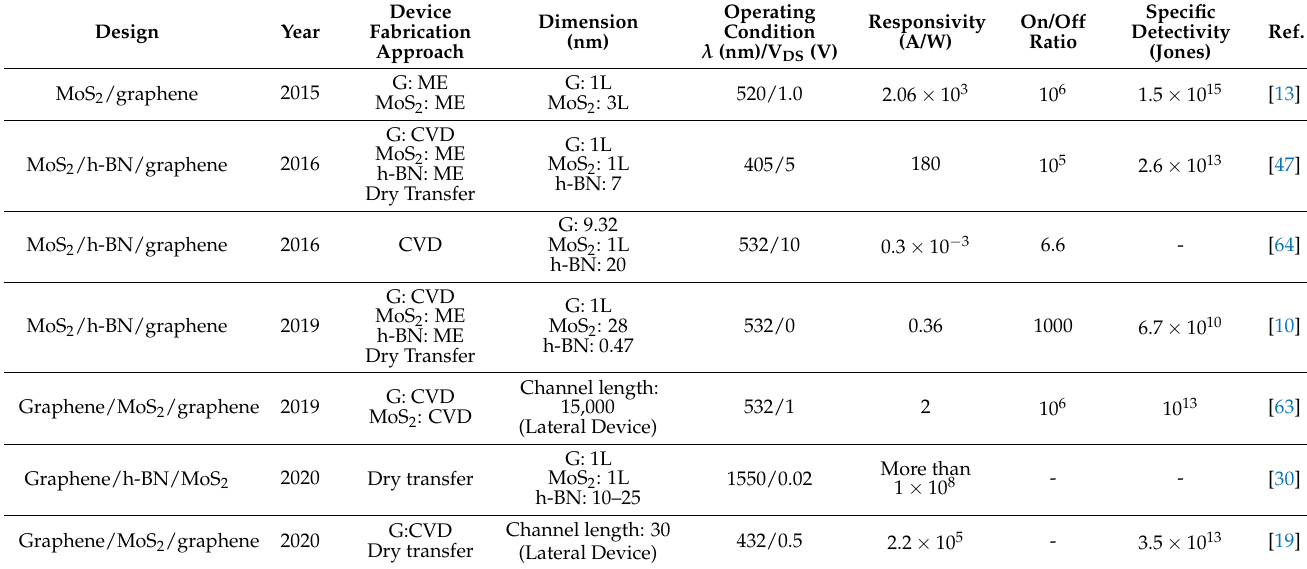
Table 2. Figures of merit for photodetectors with graphene, MoS 2 and h-BN heterostructures